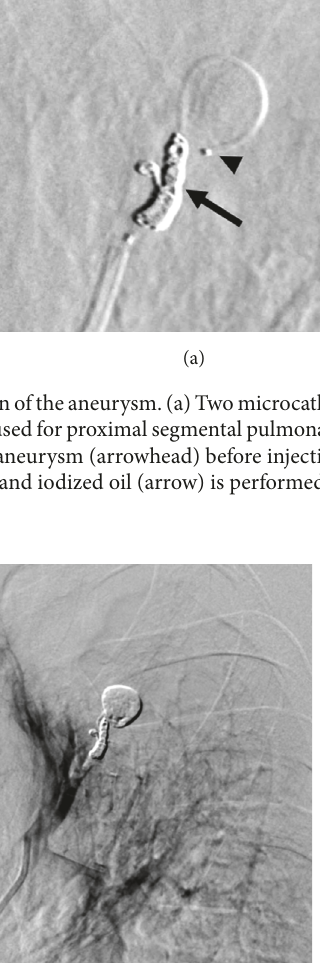
Figure 6: Postembolization assessment. There is no residual aneurysm on pulmonary angiography.